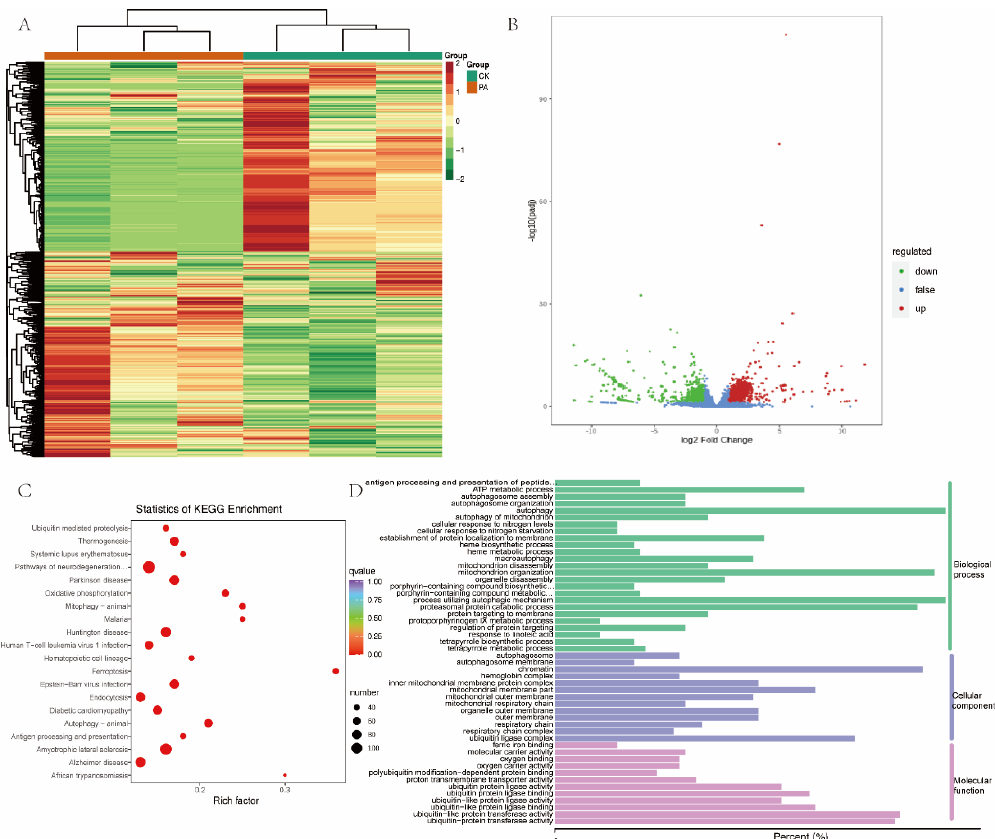
Figure 4. Differential expression of mRNAs between peanut allergy and control subjects. ( A ) heatmap showing profiles of mRNAs in the blood sample of peanut allergy group (N = 3) and control group (N = 3). ( B ) Volcano plot of all genes differentially expressed between two groups. ( C ) KEGG enrichment of differentially expressed genes. ( D ) The top 50 signaling pathways enriched by GO analysis with biological process, cellular components, and molecular function.